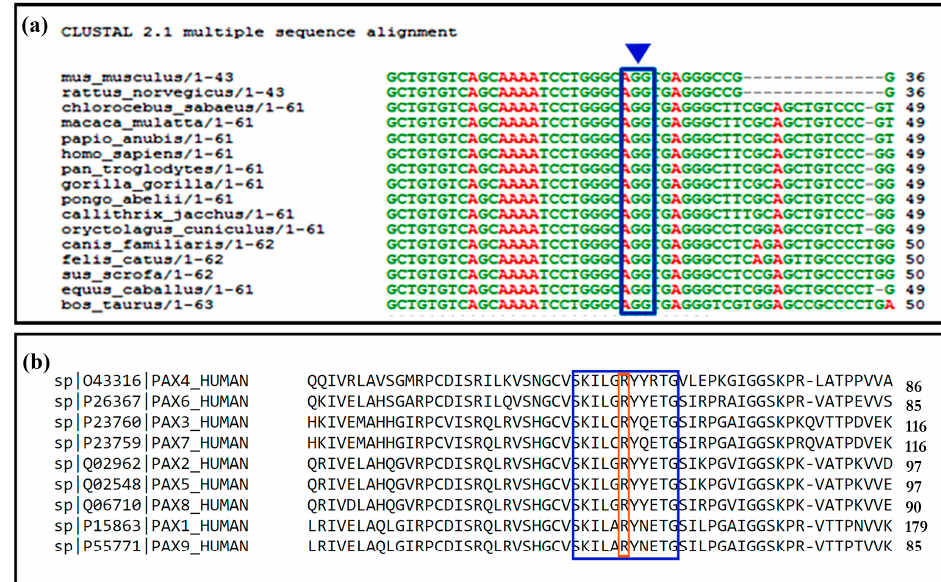
Figure 2. ClustalW output. ( a ) the alignment of the PAX2 gene sequence in 17 species of eutherian mammals, in the blue box the codon wild type AGG, the arrow indicates the 212G nucleotide of c.212G>T variation. ( b ) the alignment of the PAX2 amino acid sequences relating to the paired domain of the nine proteins of the PAX family, in the blue box the alpha helics motif, in the red box the conserved R (Arg) of p.Arg72Met.